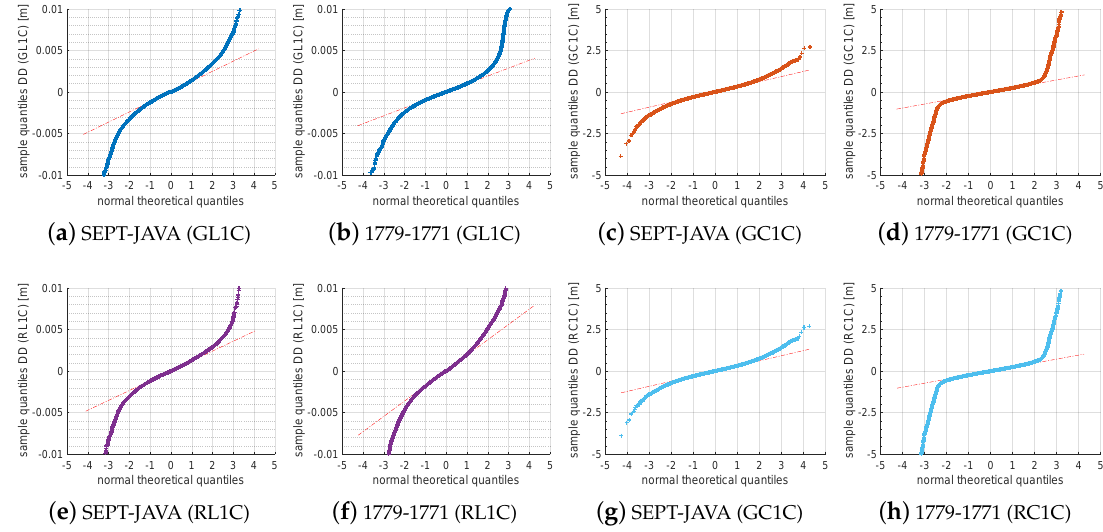
Figure 6. Quantile–quantile plots for the analysis of normal distribution of observed-minus-computed double difference residuals on a short baseline between geodetic receivers and consumer grade receivers for systems GPS and GLONASS.